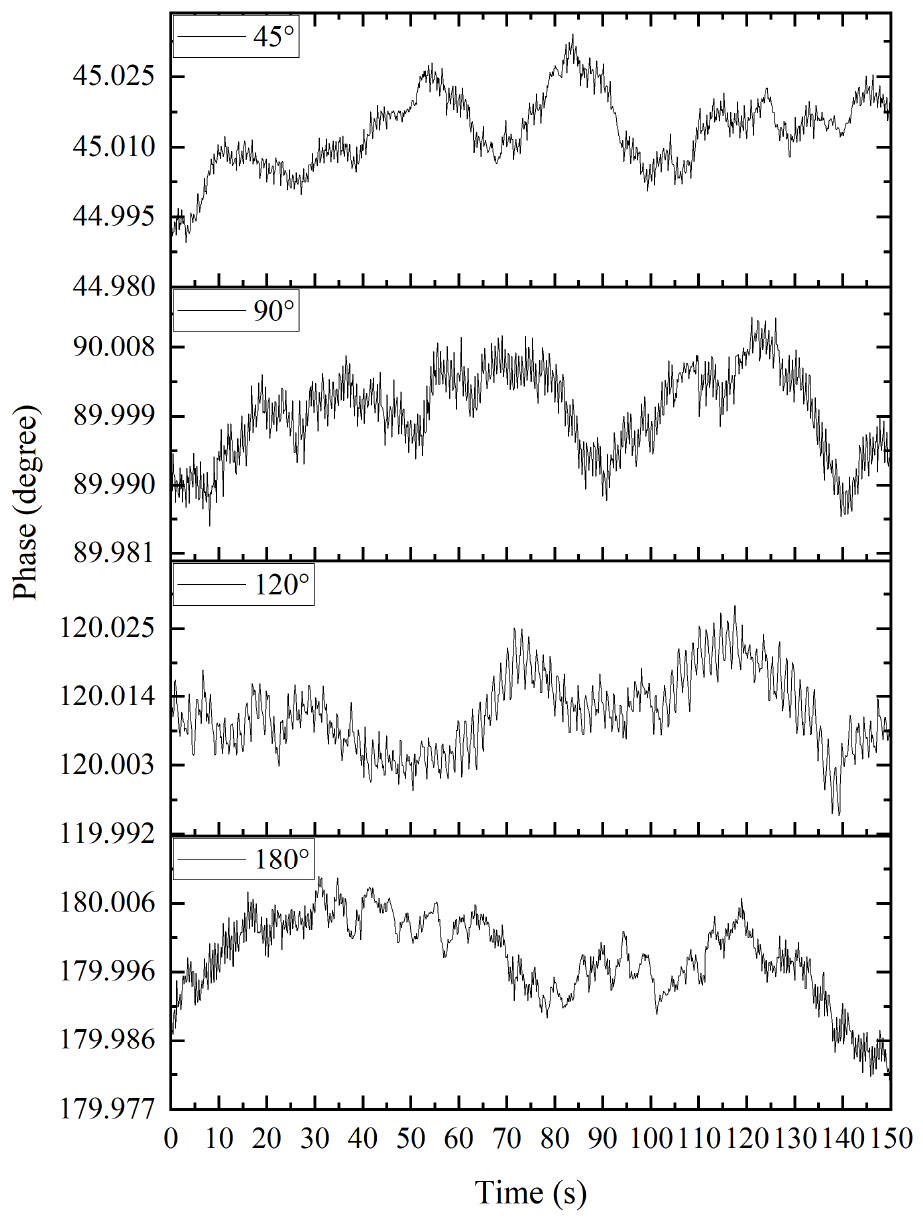
◦ , 90 ◦ , 120 ◦ and 180 ◦ phase differences using Figure 9. Measurement results of 45°, 90°, 120° and 180° phase differences using apFFT. Figure 9. Measurement results of 45